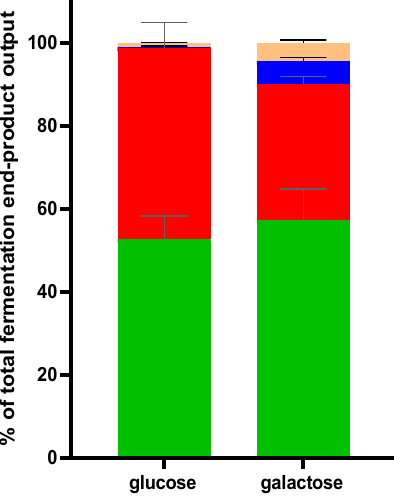
Figure 4. Relative levels of fermentation end products produced by B. longum NCC 2705 grown on glucose or galactose. Acetate (green), lactate (red), ethanol (orange) and formate (blue) levels measured in stationary phase culture supernatants.